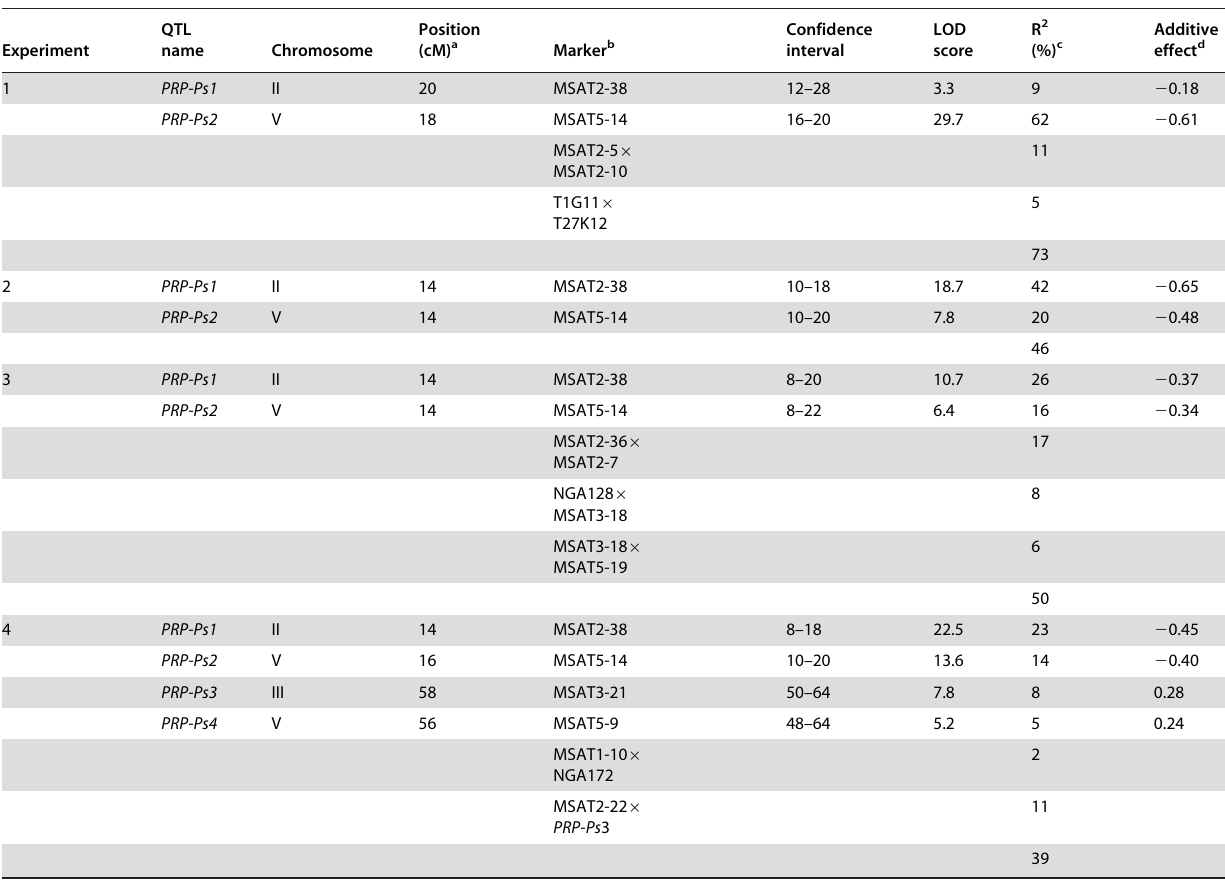
Table 2. Arabidopsis QTLs controlling partial resistance to Pseudomonas syringae pv. tomato DC3000 in the Bay-0 6